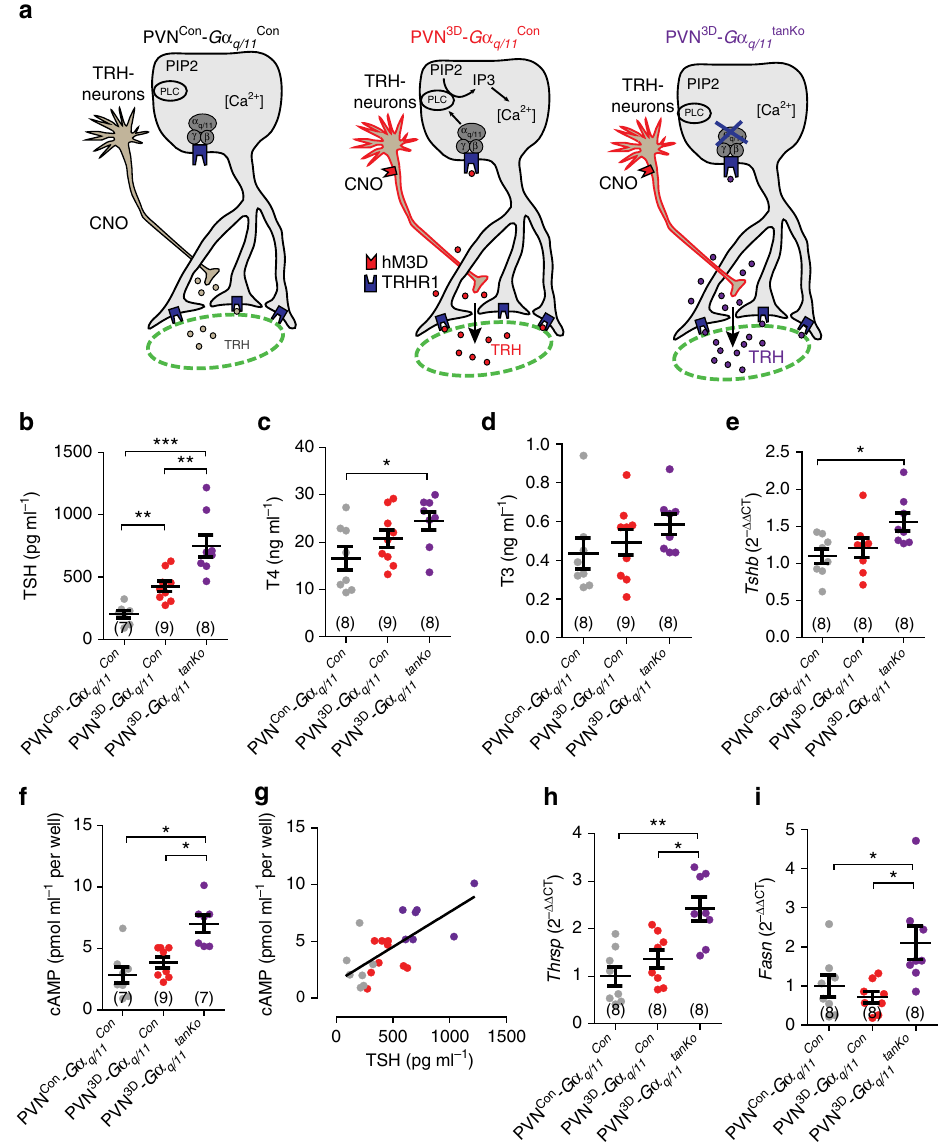
Fig. 7 The tanycyte-speci fi c de fi ciency of G α q/11 enhances the TSH release in response to activation of TRH neurons. a Schematic representation of the experimental groups. PVN Con - G α q/11 Con : G α q fl / fl :: G α 11 +/ − mice were injected with AAV-Dio2-GFP into the LV ( G α q/11 Con ) without injection of an AAV into the PVN (PVN Con ; gray ). PVN 3D - G α q/11 Con : the PVN of G α q/11 Con mice were bilaterally injected with AAV-TRH-hM3D-mCherry (PVN 3D , red ). PVN 3D - G α q/11 tanKO : a de fi ciency of the G α q/11 pathway in tanycytes was induced by injecting AAV-Dio2-iCre-2A-GFP in the LV of G α q fl / fl :: G α 11 − / − mice. In parallel, AAV-TRH- hM3D-mCherry was bilaterally injected into the PVN to generate PVN 3D - G α q/11 tanKO mice ( purple ). All mice received CNO. b – e TRH-dependent parameters 2 h after CNO (0.5mg kg − 1 body weight) administration to PVN Con - G α q/11 Con , PVN 3D - G α q/11 Con , and PVN 3D - G α q/11 tanKO mice. b TSH plasma levels. One-way ANOVA, F(2/22) = 23.6, p < 0.0001. ** p < 0.01, *** p < 0.005 between indicated groups (Bonferroni post test). c T4 plasma levels. One-way ANOVA, F(2/24) = 3.4, p = 0.05. * p < 0.05 between indicated groups (Bonferroni post test). d T3 plasma levels. One-way ANOVA, F(2/23) = 3.7, p = 0.042. p > 0.05 between groups (Bonferroni post test). e Tshb mRNA expression in the pituitary. One-way ANOVA, F(2/23) = 4.3, p = 0.027. * p < 0.05 between indicated groups (Bonferroni post-test). f As a measure of TSH activity, the intracellular cAMP concentration in CHO JP26 cells was determined 1h after stimulation with plasma of PVN Con - G α q/11 Con , PVN 3D - G α q/11 Con , or PVN 3D - G α q/11 tanKO mice. Plasma was collected 2h after CNO stimulation. One-way ANOVA, F(2/22) = 12.7, p = 0.0003. * p < 0.05 between indicated groups (Bonferroni post test). g Linear correlation of TSH plasma concentrations (from b ) and TSH